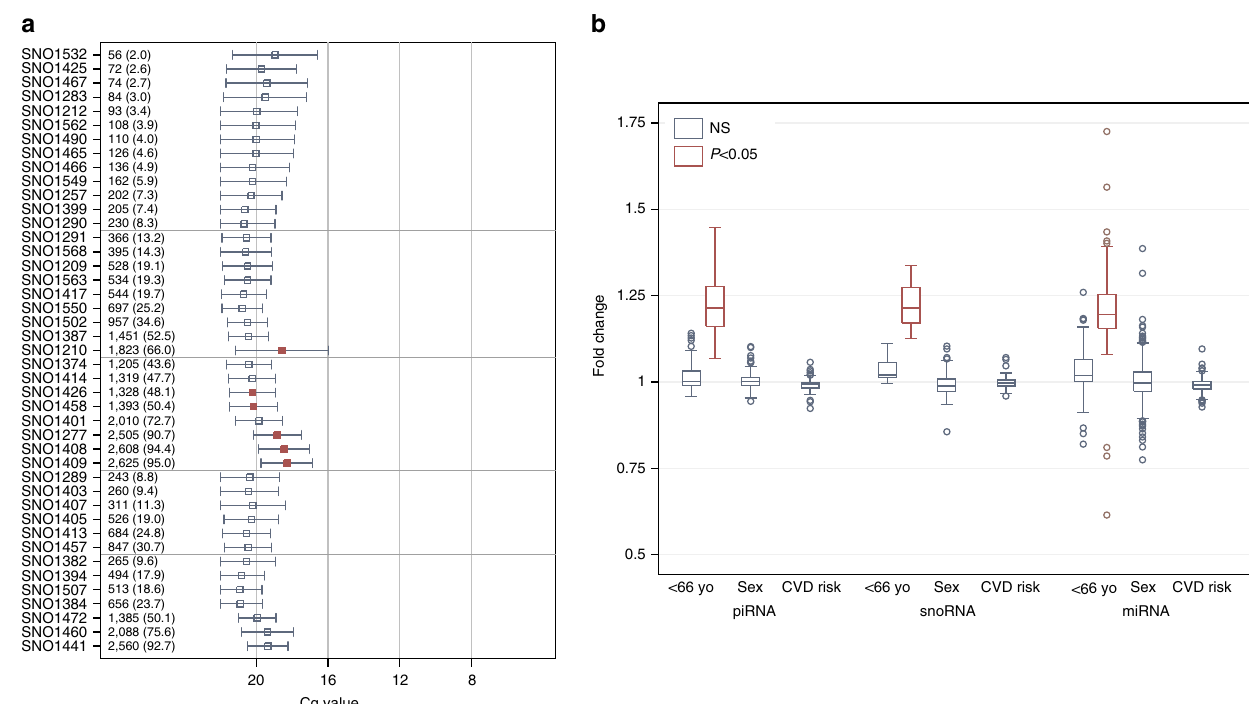
Figure 5 | Measurement of plasma snoRNAs and association with age and sex by RT-qPCR in 2,763 FHS participants. ( a ) The prevalence and quantity of expression for each snoRNA are measured. RNAs are sorted from least to most expressed with the N and per cent expressed (that is, Cq o 23). The quantification cycle (Cq) axis is sorted in reverse order so that expression increases from left to right along the axis. The mean ( ± s.d.) Cq values are depicted with the horizontal capped lines and small squares for each RNA. Light horizontal grey gridlines stratify RNAs by per cent of expression at o 10% and 4 90%. ( b ) Range of fold-change values associated with age (median split at 66.5 years), sex and cardiovascular risk using the Framingham Risk Score. Red squares or boxes are used for statistically significant associations ( P o 0.05 after adjusting for multiplicity using the FDR) and navy squares and/or boxes are used for RNAs not meeting statistical significance. There were no statistically significant associations with sex for any of the RNAs assessed. In contrast, 39% ( n ¼ 133) of miRNAs, 13% ( n ¼ 13) of piRNAs and 21% ( n ¼ 9) of snoRNAs were associated with age. As shown in Figure 4b and 5a, all piRNAs and snoRNAs and all but three of the miRNAs showed increased expression in subjects o 66.5 years of age. All supporting values included age and sex of participants are included in Supplementary Tables 1–3 and Supplementary Data